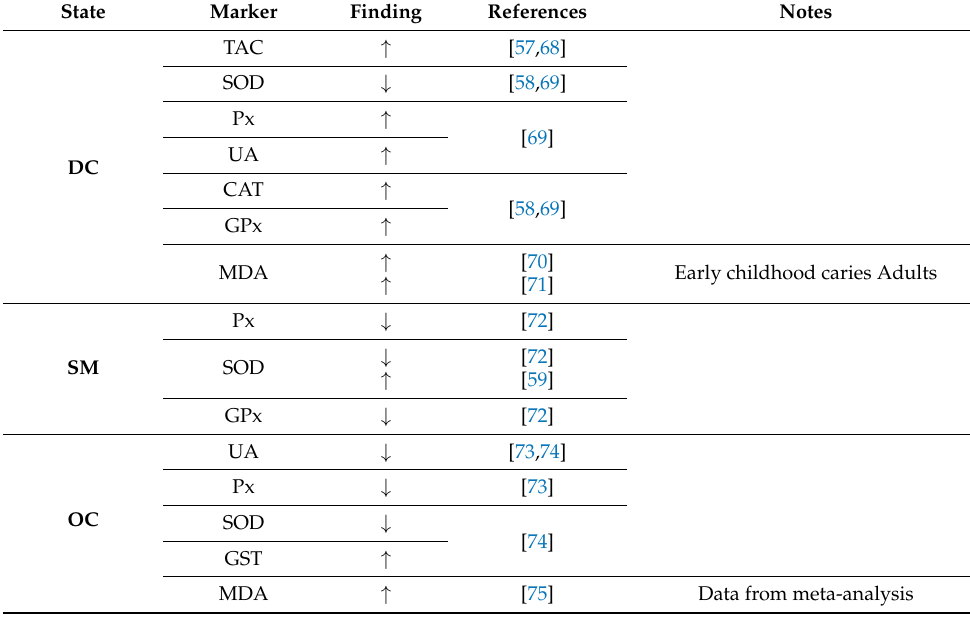
Table 1. Salivary redox markers in various pathological